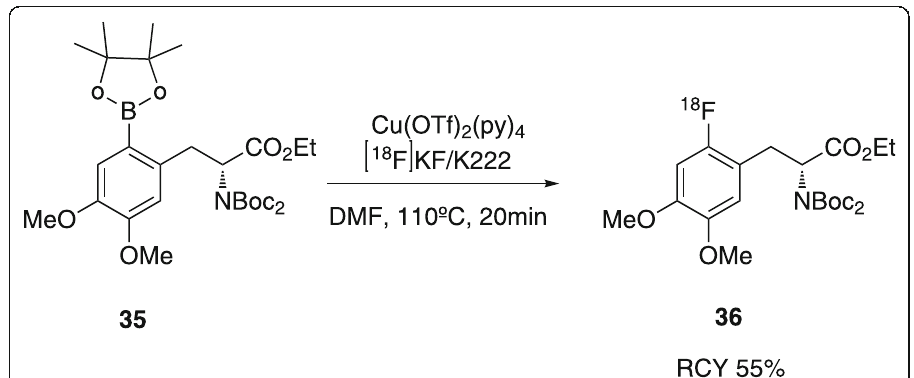
Fig. 13 Copper-mediated synthesis of protected 6-[ 18 F]fluoro-3,4-dihydroxy- L -phenylalanine starting from an aryl boronic derivative precursor (Tredwell et al., 2014)